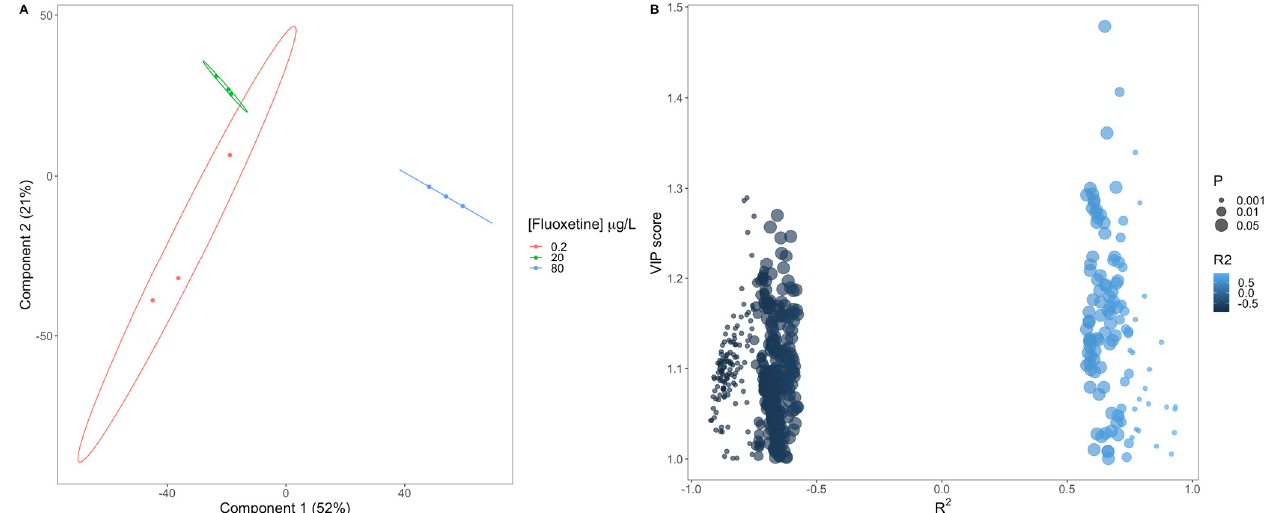
Figure 6. Mass intensity fold-change Variable Importance in Projection Partial Least-Squares Discri- minant Analysis (VIP-PLS-DA) biplot ( A ) and a scatterplot of the attained VIP scores and correlation coefficients (R 2 ) and significance classes (P) between the calculated fold-change and the fluoxetine exogenous dose applied ( B ), for the detected mass values with VIP score values above 1.